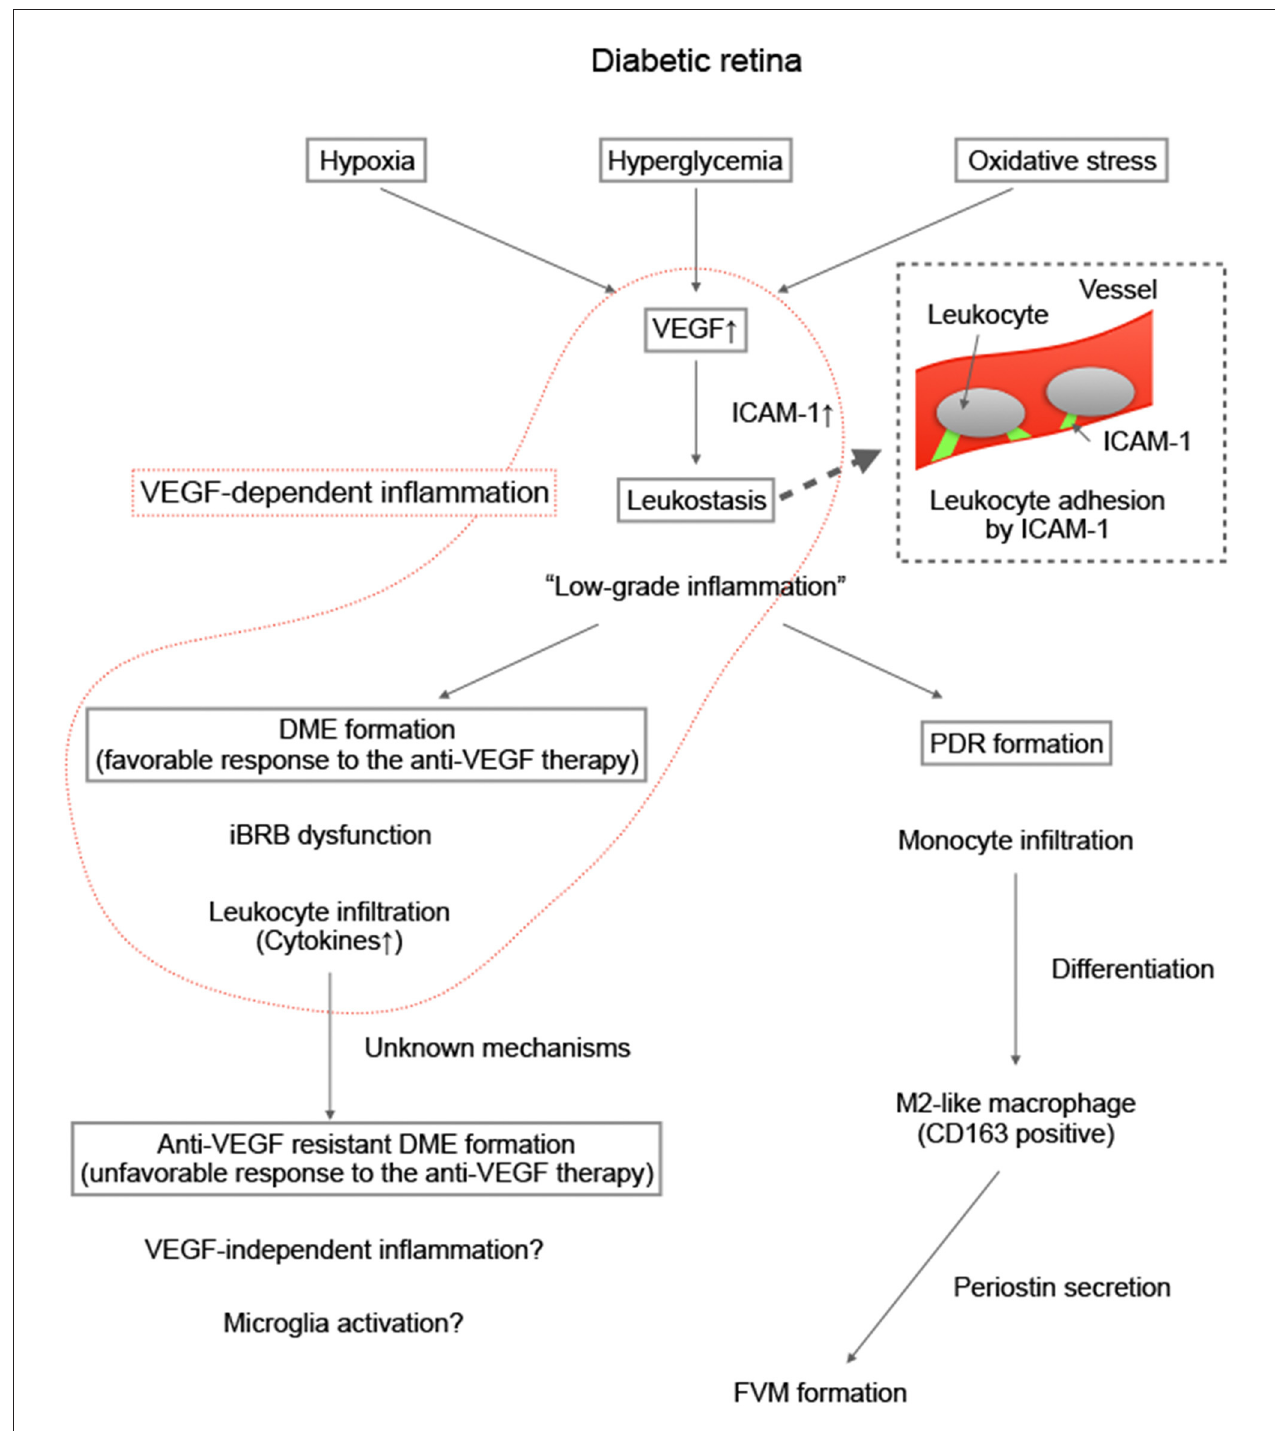
FIGURE 2 | Summary of our hypothesis on the formation of proliferative diabetic retinopathy and antivascular endothelial growth factor resistant diabetic macular edema. Diabetic macular edema (DME) animal models such as Akimba mouse models have been developed. The details of the involvement of inflammation in the pathogenesis of DME are expected to be identified in the